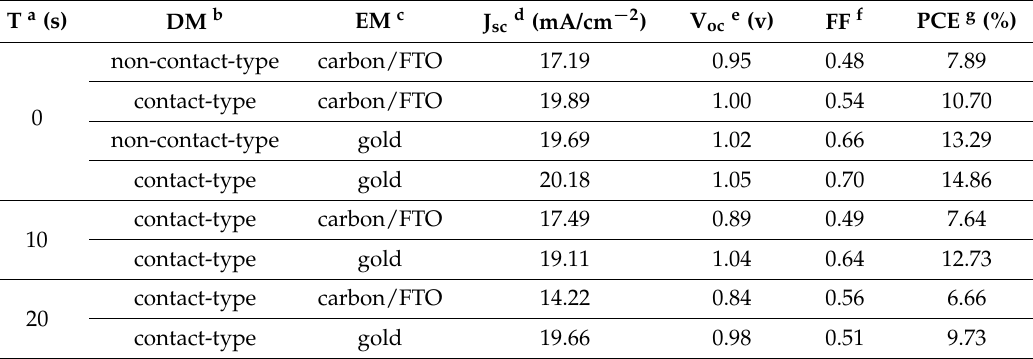
Table 1. Parameters of contact-type or non-contact-type processed PSCs with carbon/FTO composite electrode or gold electrode prepared by sequential deposition route with different PbI 2 annealing times under